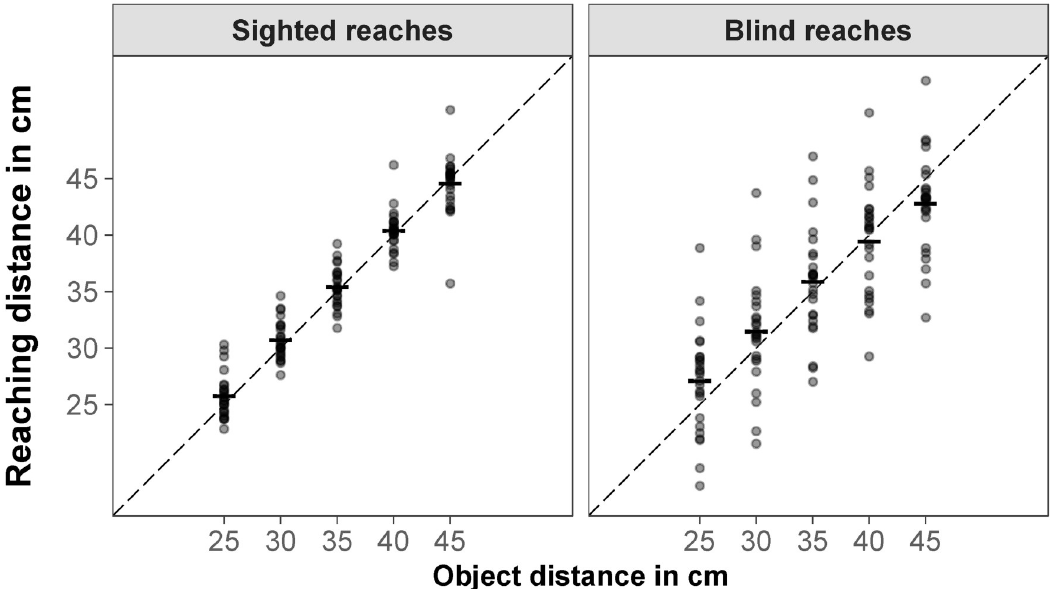
Fig 3. Reaching distance in congruent trials. Mean sighted and blind reaches for object distance; each data point represents the median for one participant (aggregated over six objects); the dashed black line represents the object distance as specified by binocular disparity and familiar size.